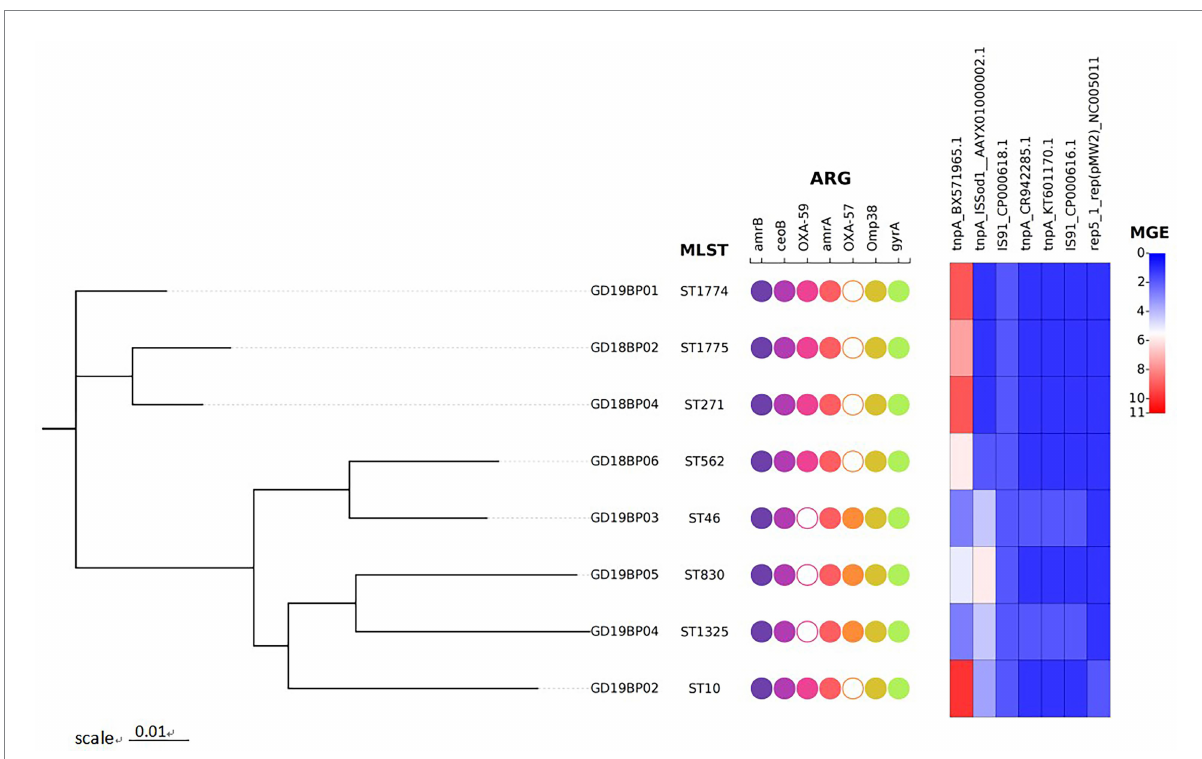
FIGURE 1 Phylogenetic tree of the eight B. pseudomallei strains recovered from Guangdong, China. The figure represents the genetic features of these strains. Circles in the figure are binary plots, with filled colors indicating that these isolates were positive for the genetic features mentioned on the top, while hollow white circles indicate that the corresponding genes are missing in that sample. The heatmap on the right shows the number of mobile genetic elements